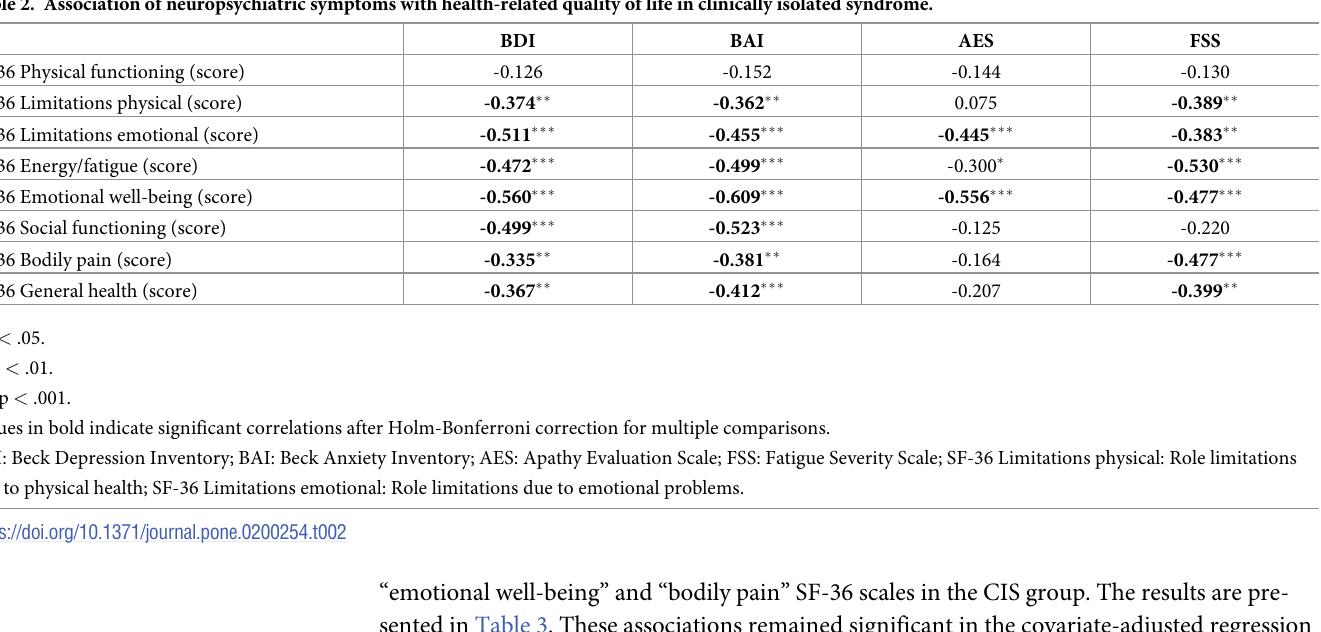
Table 3. Association of EDSS, MSNQ and SDMT scores with neuropsychiatric symptoms and health-related qual- ity of life in clinically isolated syndrome.